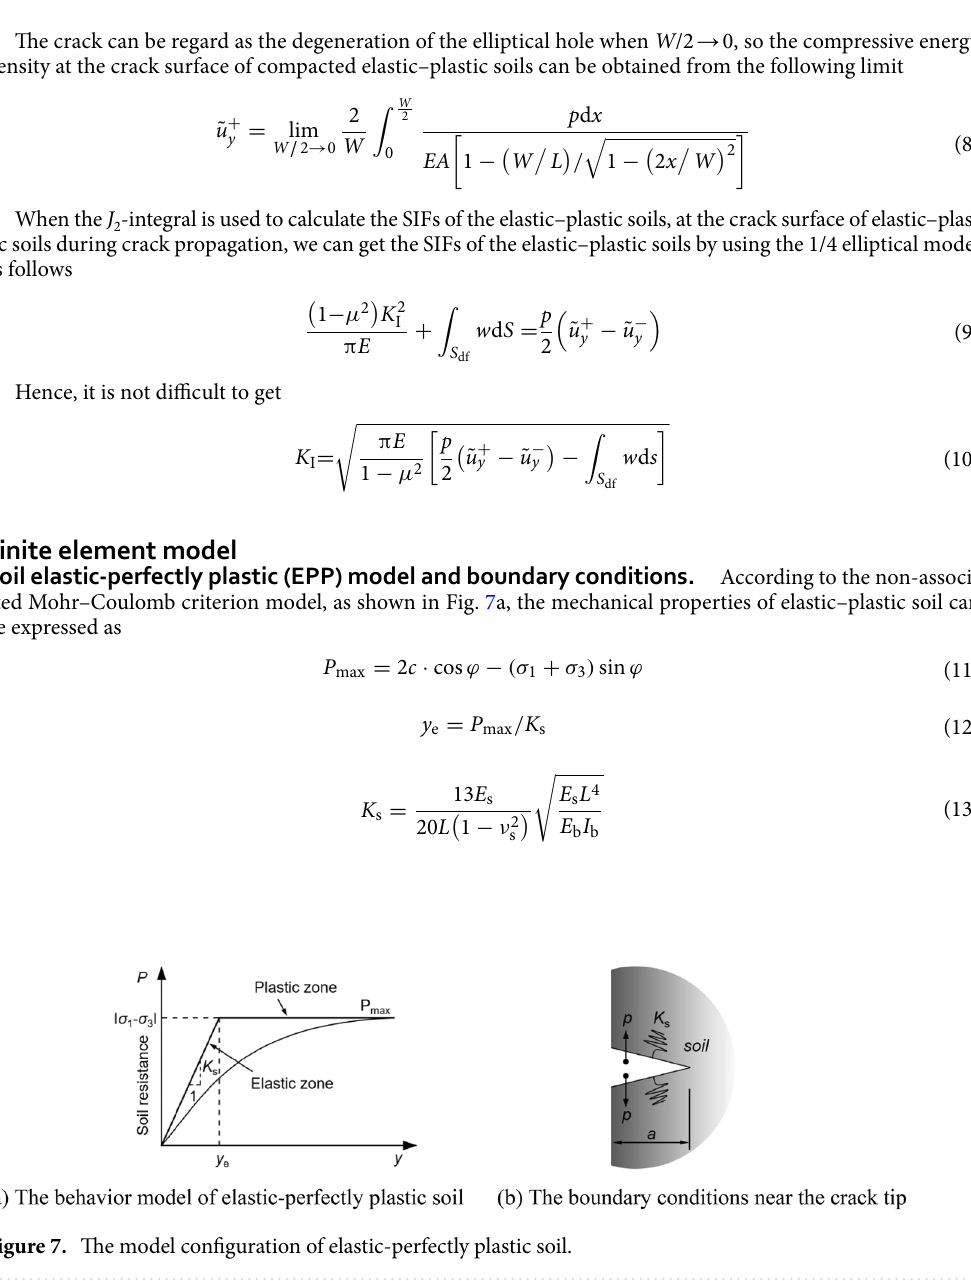
Figure 7. The model configuration of elastic-perfectly plastic